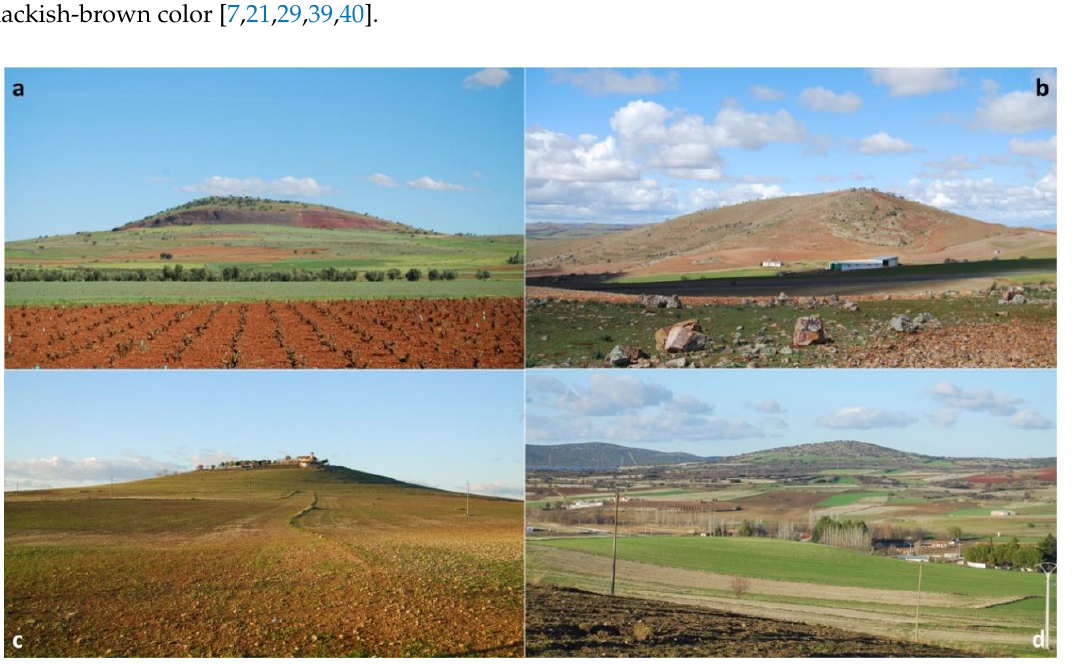
Figure 5. Some examples of cinder cones: ( a ) La Yezosa (Almagro); ( b ) Cerro Gordo (Granátula- Valenzuela de Calatrava); ( c ) Cabeza del Rey (Poblete); ( d ) La Arzollosa (Alcolea de Calatrava).